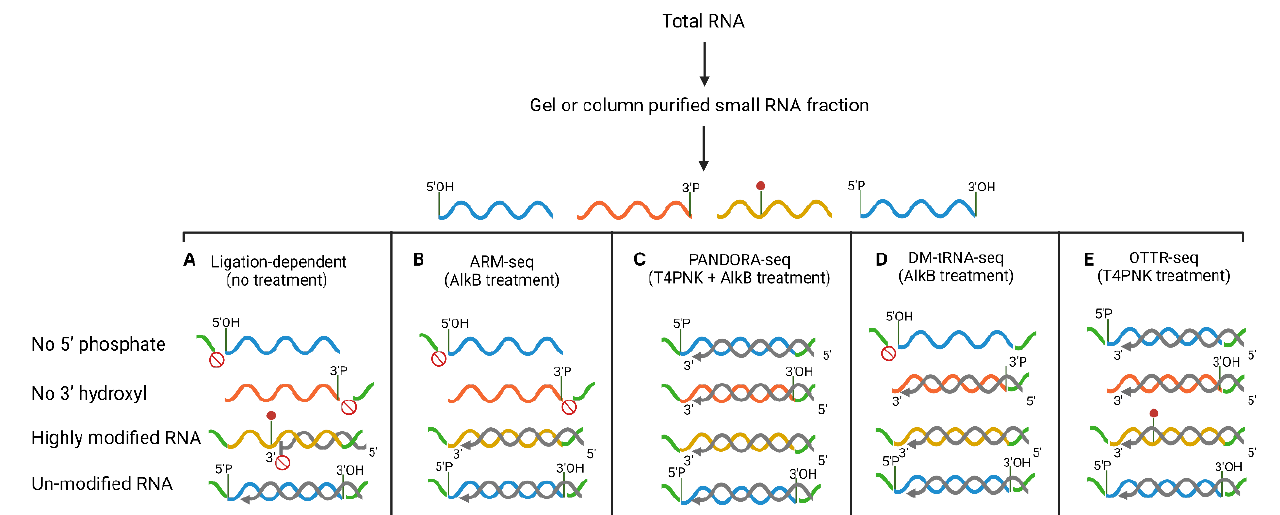
Figure 1. sRNA sequencing approaches: (Different colors represent RNA types harboring specific modification or chemical structures.) ( A ) Ligation-based protocols require 5′ phosphate and 3′ hy- droxyl groups for adaptor ligation. In addition, many reverse transcriptase (RT) enzymes cannot read through the hard-stop modifications on highly modified RNA molecules and fall off prema- turely. Therefore, small RNAs that are endowed with the above characteristics are not efficiently sequenced. ( B ) To allow sequencing of highly modified RNA molecules, in ARM-seq, RNA is pre- treated with AlkB demethylase to remove specific methyl modifications that interfere with RT. ( C ) In addition to using AlkB treatment, PANDORA-seq also uses pretreatment of RNA with T4 Poly- nucleotide Kinase (PNK) to allow efficient 5′ and 3′ end adaptor ligation. ( D ) DM-tRNA-seq utilizes a combination of AlkB demethylase and a thermostable template-switching reverse transcriptase- TGIRT to overcomes 3′ structure and modification-induced RT stop. ( E ) OTTR utilizes a retroele- ment reverse transcriptase that allows the addition of 5′ and 3′ adaptors in a single tube during cDNA synthesis by serial template switching.